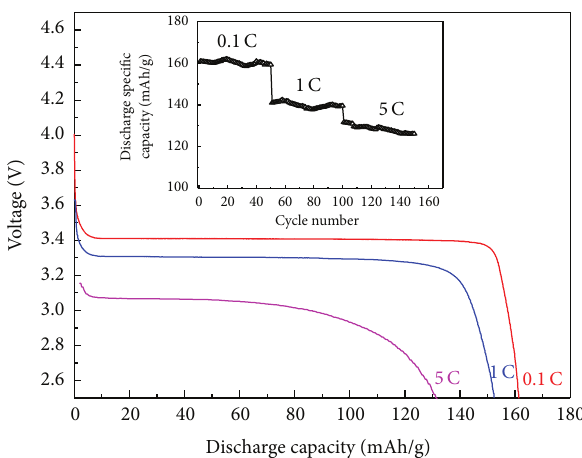
Figure 5: The initial charge/discharge curves and cycle performance.